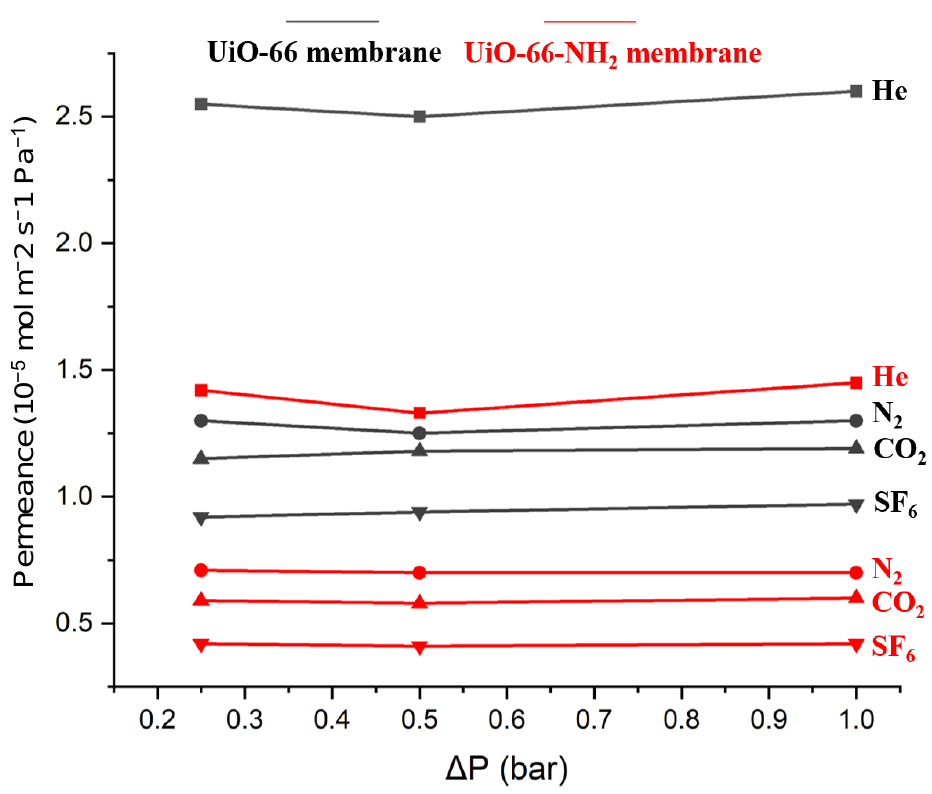
Figure 4. Single gas permeance (10 −5 mol m −2 s −1 Pa −1 ) of He, N 2 , CO 2 and SF 6 versus transmembrane pressure ( ΔP ) for UiO-66 MOF-based membrane and UiO-66-NH 2 MOF-based membrane.